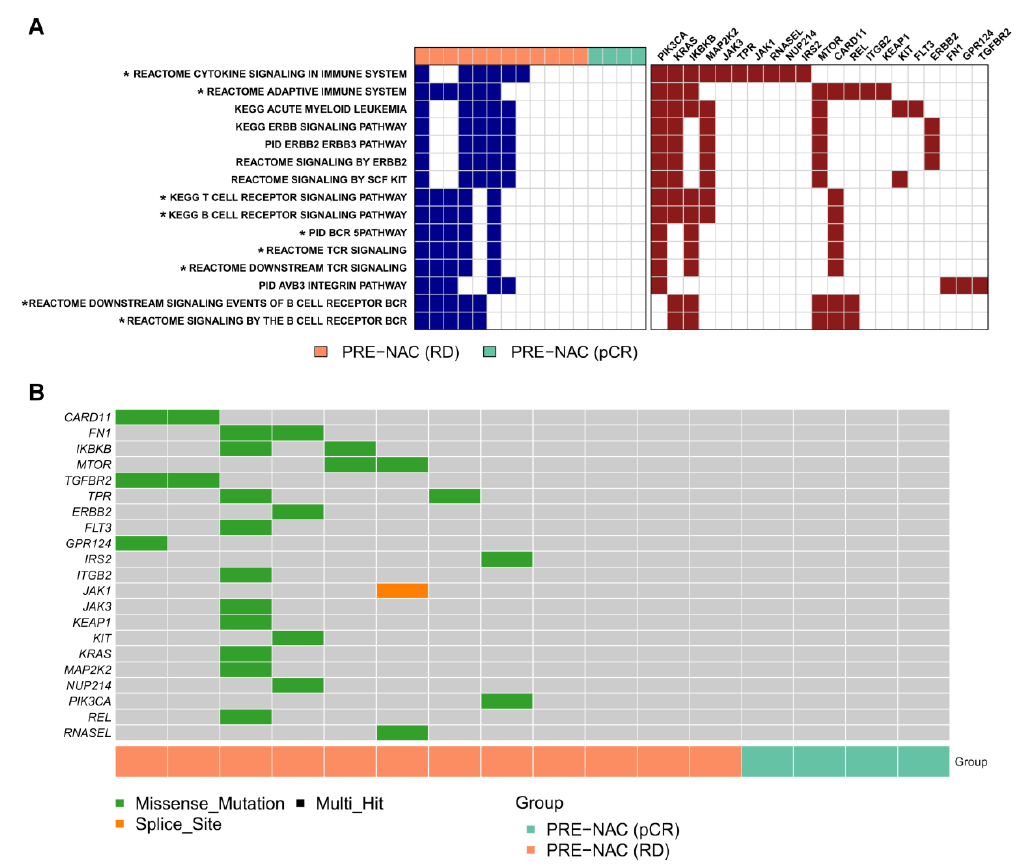
Figure 2. Mutated pathways associated to pathological Complete Response (pCR) in pre-neo-adjuvant chemotherapy (NAC) tumors. ( A ) Heatmap showing the 15 pathways (rows) that are preferentially mutated in residual disease (RD) patients compared to pCR ones (columns). Asterisks indicate immune-related pathways. Blue squares indicate that the pathway is mutated in the sample. Mutated genes (red squares) included in each pathway are reported. ( B ) Oncoplot showing the mutational status of the genes belonging to the 15 pathways associated to NAC response across pre-NAC